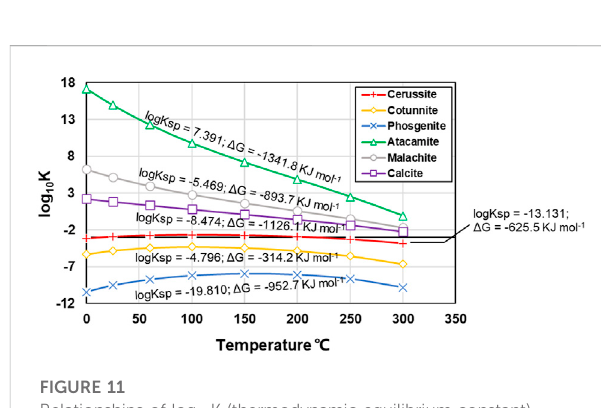
FIGURE 11 Relationships of log 10 K (thermodynamic equilibrium constant) versus temperature (in Celsius) against different carbonate precipitations applied to Pb and Cu